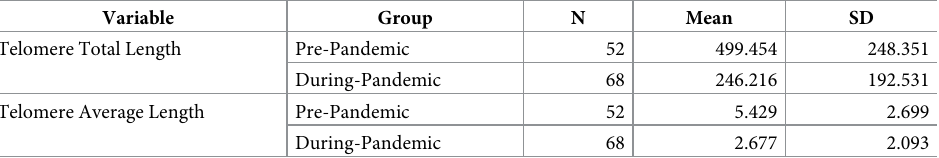
Table 4. Descriptive statistics for telomere length measures by pre- and during pandemic groups.